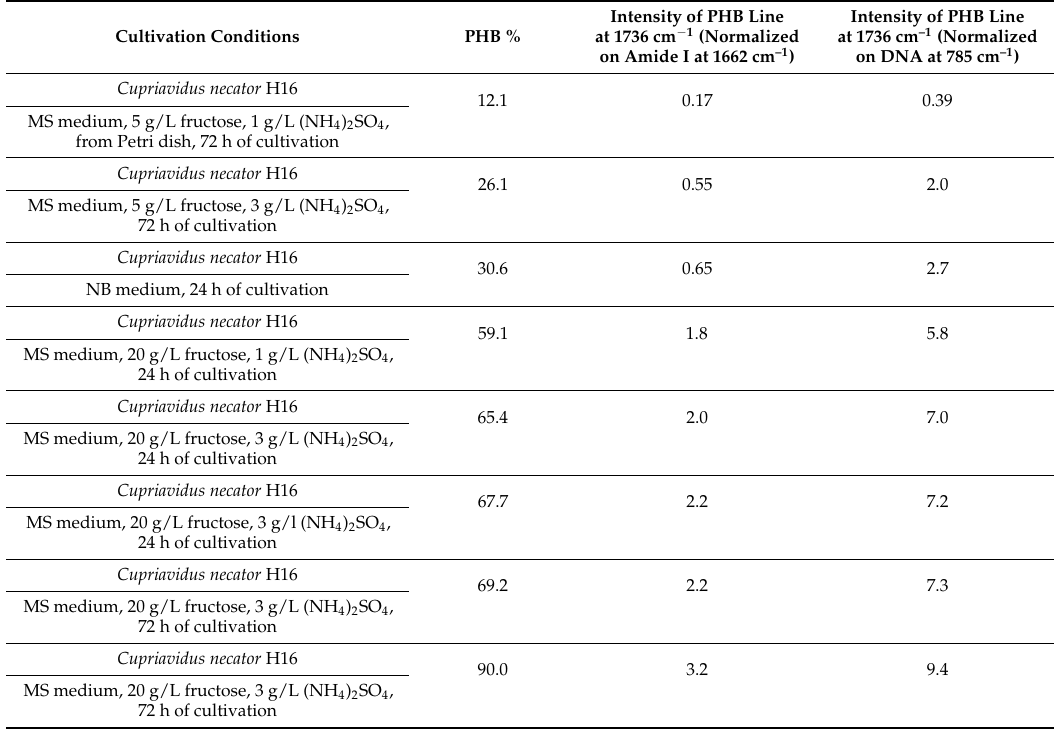
Table 1. Data used for the construction of calibration curves shown in Figure 2. PHB reference values were estimated using the GC technique. Cultivation conditions for each reference sample are also